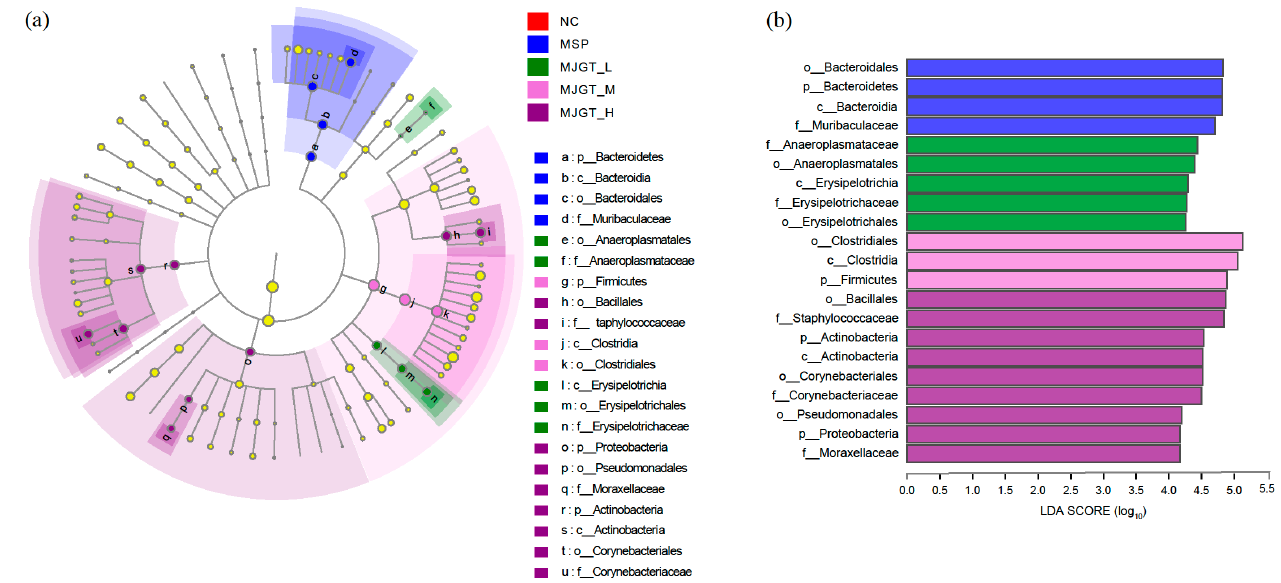
Figure 7. Hierarchical tree map ( a ) and the linear discriminant analysis histogram ( b ) of the gut microbiota in treatments ( n = 4 for each group).